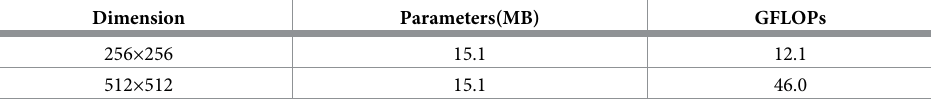
Table 4. Complexity measure evaluation of CSP_UNet network model with different input sizes.